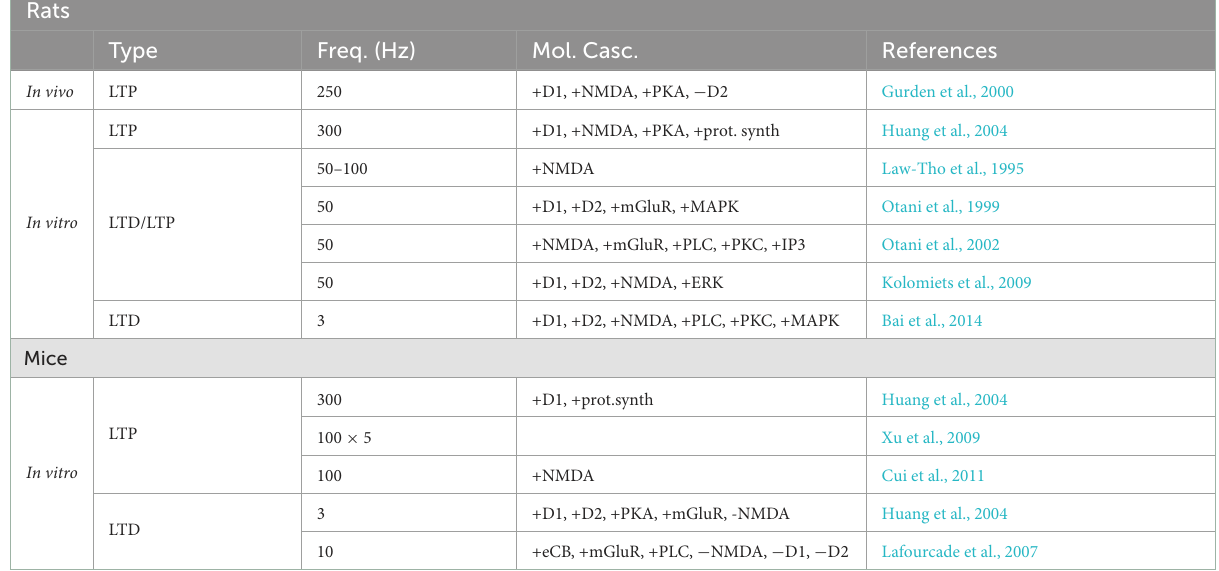
TABLE 2 Experimental studies on DA modulation of long-term synaptic plasticity in rodent PFC.